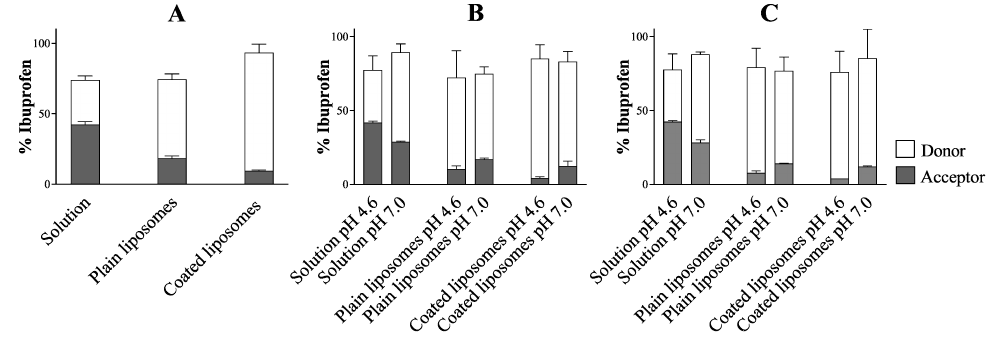
Figure 4. Percentage of ibuprofen recovered at the end of the permeability experiment in the donor and acceptor compartment of the Phospholipid Vesicle-based Permeation Assay (PVPA) barriers using ( A ) Setup 1 (i.e., naked barriers), ( B ) Setup 2A and B (i.e., mucus), and ( C ) Setup 3A and B (i.e., mucus + SVF) (mean ± SD, n = 18).